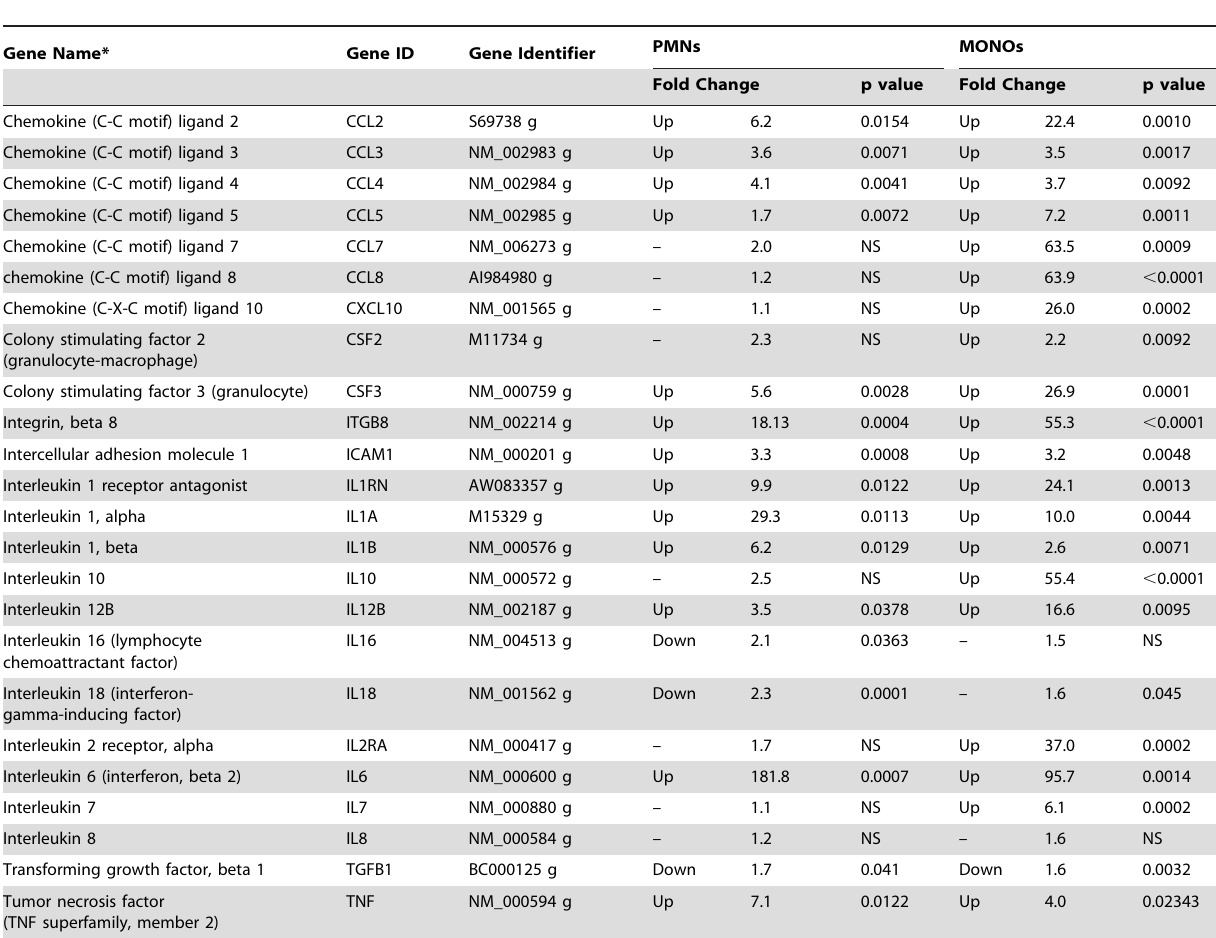
Table 2. Gene expression measured by genome-wide microarray profiling after 4 h of endotoxin stimulation in polymorphonuclear cells (PMNs) and monocytes (MONOs) from the newly born (N=